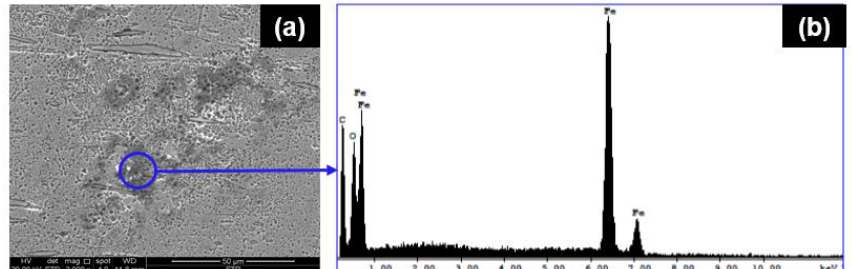
Figure 15: (a) Optical micrograph of the corroded shell showing corrosion deep inside the structure, (b) EDS analysis for the corrosion product shown in Figure